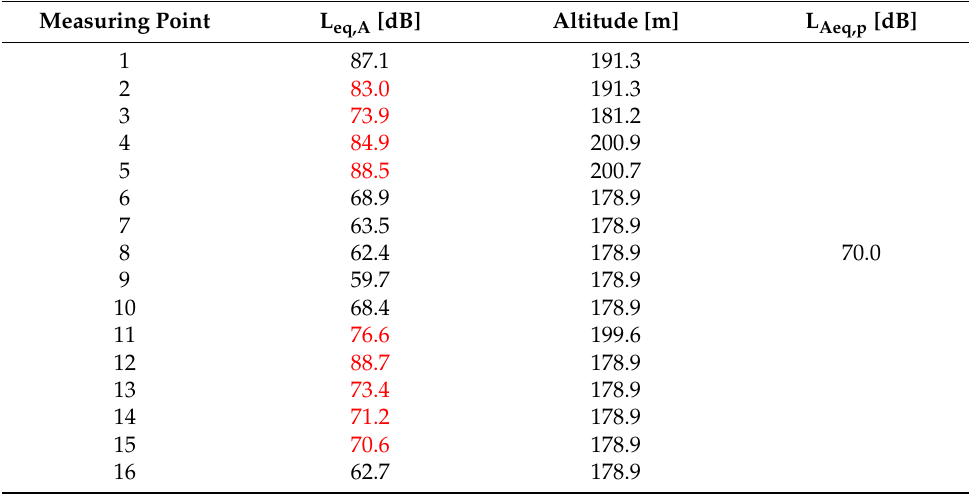
Figure 5. Measuring points at the sandy gravel production plant. Table 2. Noise values measured at the sandy gravel production plant. Table 2. Noise values measured at the sandy gravel production